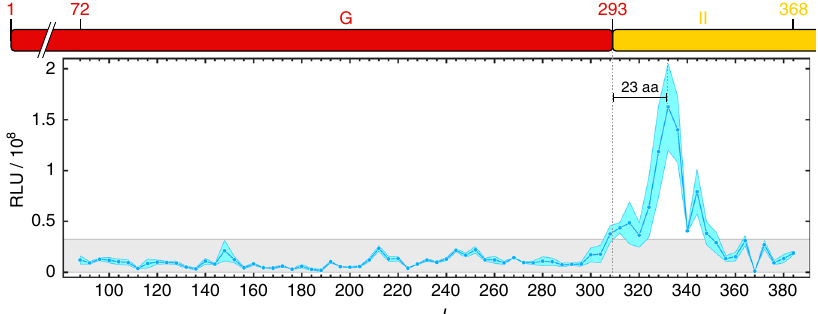
Fig. 4 Folding pro fi le of EF-G nascent chains. The plot shows the luminescence readings from 75 individual cultures. The blue line indicates the mean from three independent measurements, with the standard deviation indicated by the cyan-colored area. A strong peak is centered around L = 332, where the G- domain has been extruded from the ribosome. Shorter and longer constructs outside the main peak region show only background luminescence (gray box indicates 20% of maximum signal), suggesting the absence of folding intermediates before synthesis of the entire domain is complete. The EF-G domain diagram on top is drawn for reference to indicate synthesis progress. Sequence positions (domain diagram, top) are offset from L ( x -axis of the plot) by 16 amino acids, the length of the SecM arrest peptide that is incorporated into the nascent